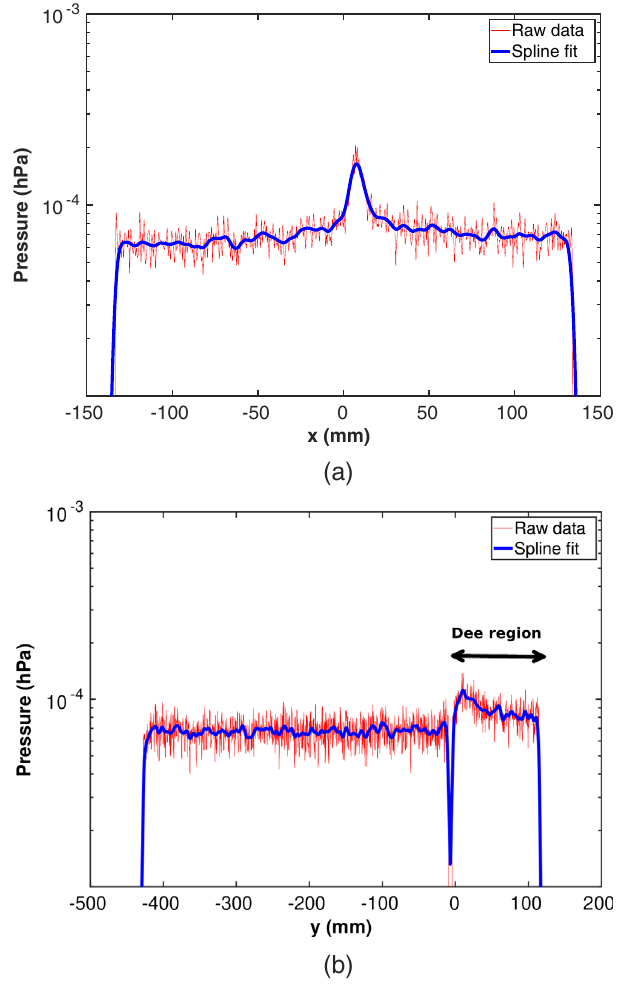
FIG. 3. Pressure level along x -coordinate at the gap center (a) and along y -coordinate at x ¼ 0 (b). The figures are referred to the cyclotron center (see Fig. 2). Thus, y -positive values in subfigure (b) correspond to the dee region, whereas the negative part represents the dummy-dee area and the rest of the vacuum chamber. The red line represents the raw data from M OLFLOW + simulations and the blue line is a spline